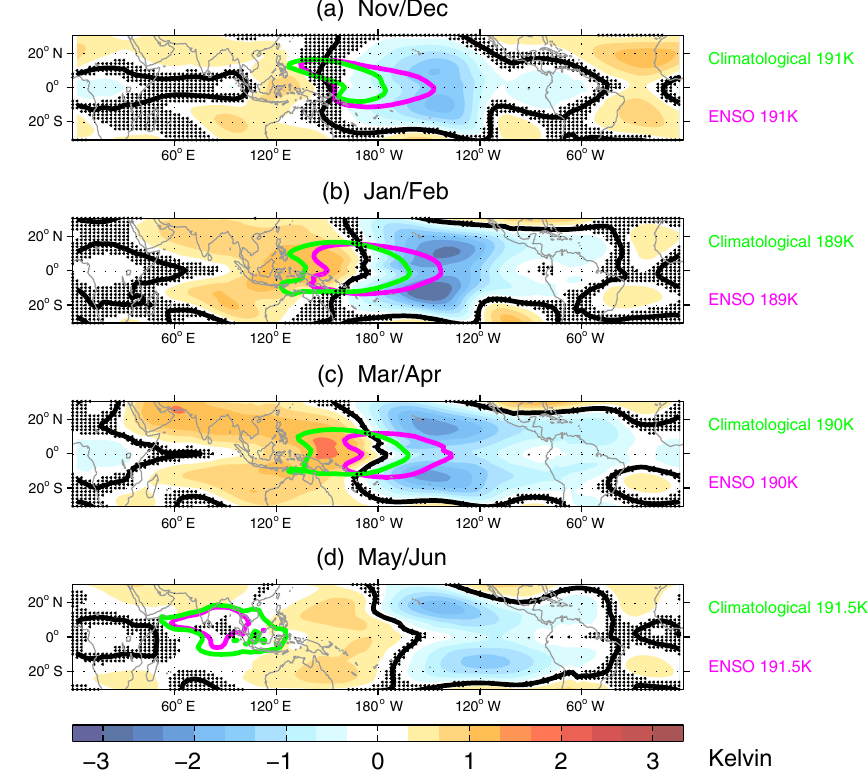
Figure 7. As in Fig. 6 but for all ENSO events except 1982/1983 and 1997/1998 in the GEOSCCM AGCM